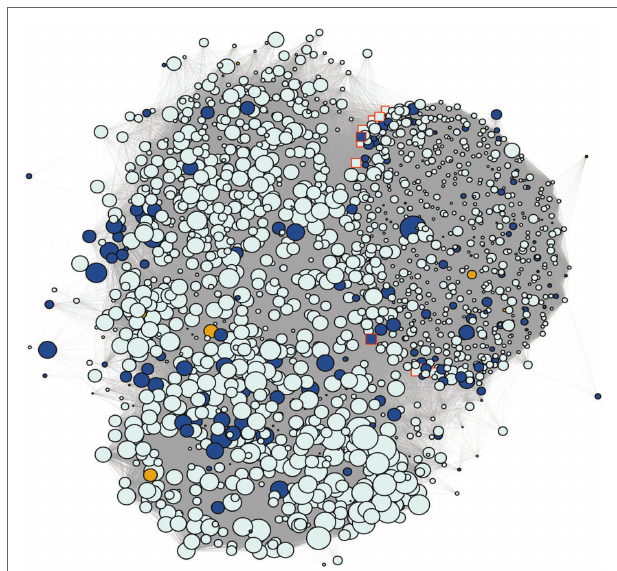
FIGURE 5 | Coexpression network containing the SNP gene modules discovered by GWAS. Yellow shows the genes annotated for the snpsGWAS, blue shows the genes annotated for the snpsLD and gray shows the genes identified in the modules. The highlighted genes with a red border represent the 10 hubs with the most connectivity, while the size of the nodes shows the number of connected genes.